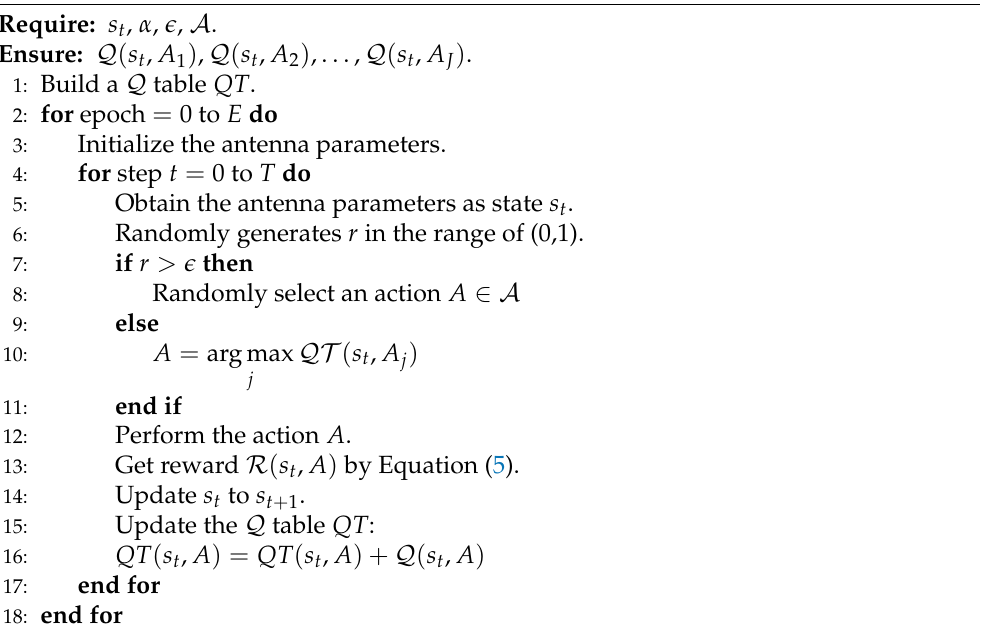
Algorithm 1 Q − learning method for HAPS antenna